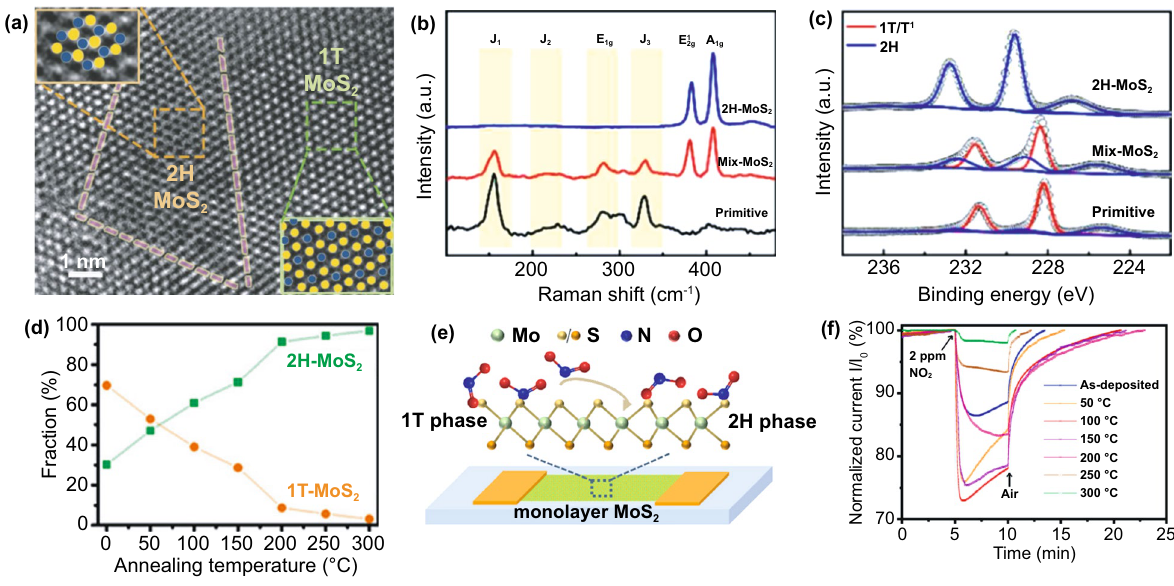
Fig. 13 a HRTEM images of 1 T/2H MoS 2 . Reproduced with permission from Ref. [201]. Copyright 2018, Wiley-VCH. b Raman spectra and c XPS spectra for the primitive 1 T’-MoS 2 nanosheets. The mix-MoS 2 represents the exfoliated MoS 2 nanosheets obtained through butyl lithium intercalation. Reproduced from Ref. [202] with permission. Copyright 2017 The Royal Society of Chemistry. d Relative fractions of 1 T and 2H phases as a function of temperature. e Schematic illustration of NO 2 detection of 1 T/2H MoS 2 . f Sensing responses of as-deposited and thermal- annealed